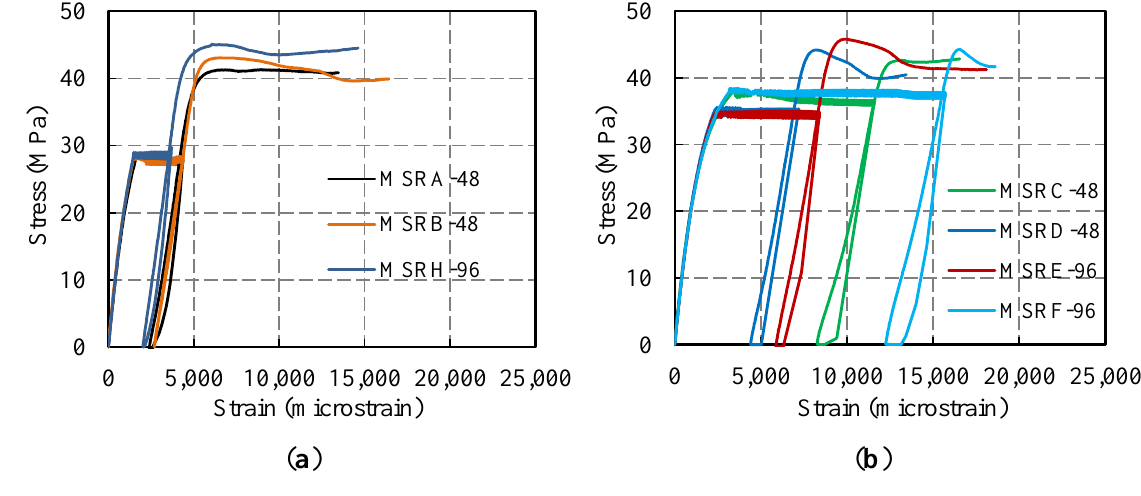
Figure 14. Medium-strength concrete residual capacity tests: 48 h versus 96 h of loading.